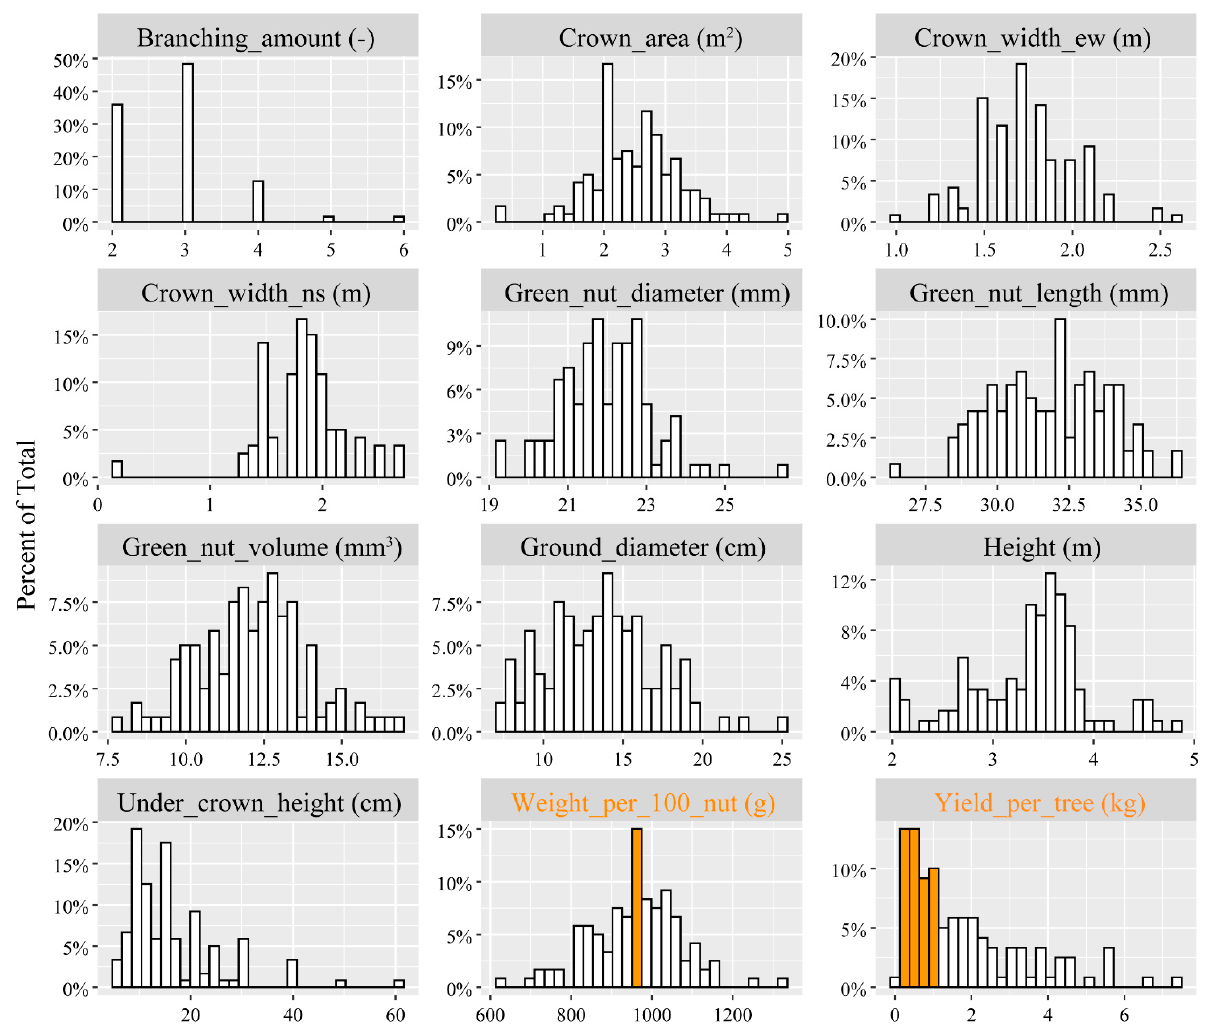
Figure 1. Distribution of traits. Note that the green nut yield per tree is not normally distributed ( p < 0.05; checked with a Shapiro–Wilk test). The average weight _per_100_nut was approximately 1.0 ± 0.1 kg and the average green nut volume was 12.3 ± 1.9 cm 3 . The green nut yield per tree was 1.8 ± 1.6 kg, but it lay within a wide range (0.1–7.5 kg) with a high variation (CV = 86.7%). The results suggest that the measured Chinese Torreya trees had a similar green nut size but varied in the whole-tree green nut yield. The weight _per_100_nuts followed a normal distribution ( p > 0.05), while the green nut yield per tree was skewed to the left ( p < 0.05; Figure